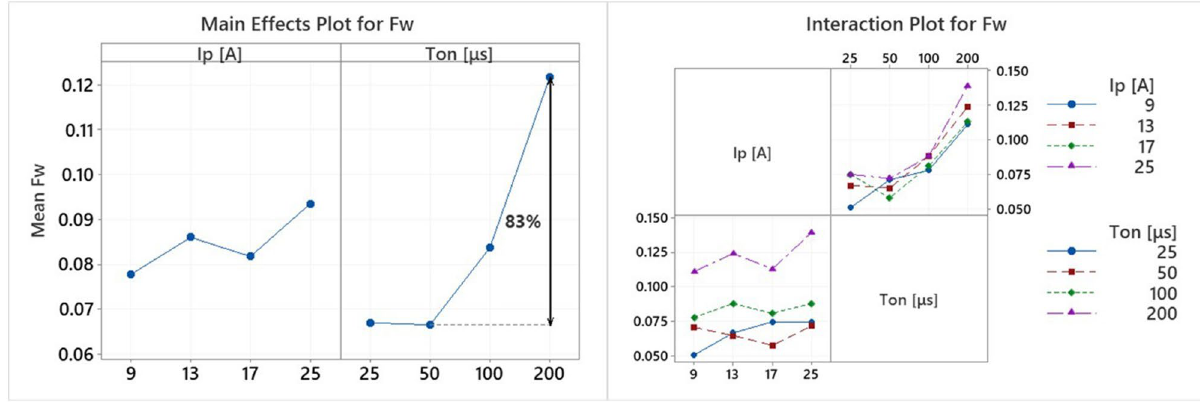
Figure 13. Main effects plot and interaction plot of F w .